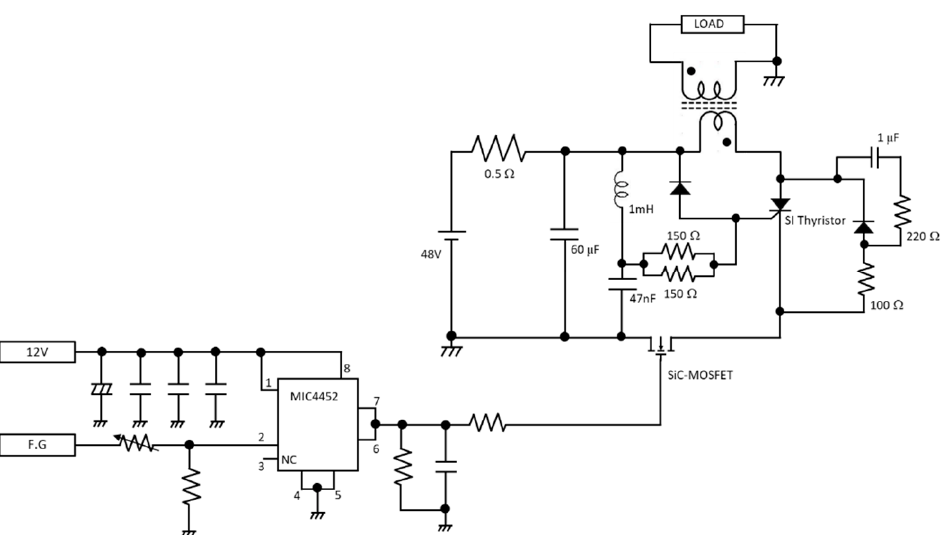
Figure 3. Schematic diagram of IES pulsed power generator used to generate PEF. The switch used for the inductive energy storage (IES) system was an N-channel SiC power MOSFET.